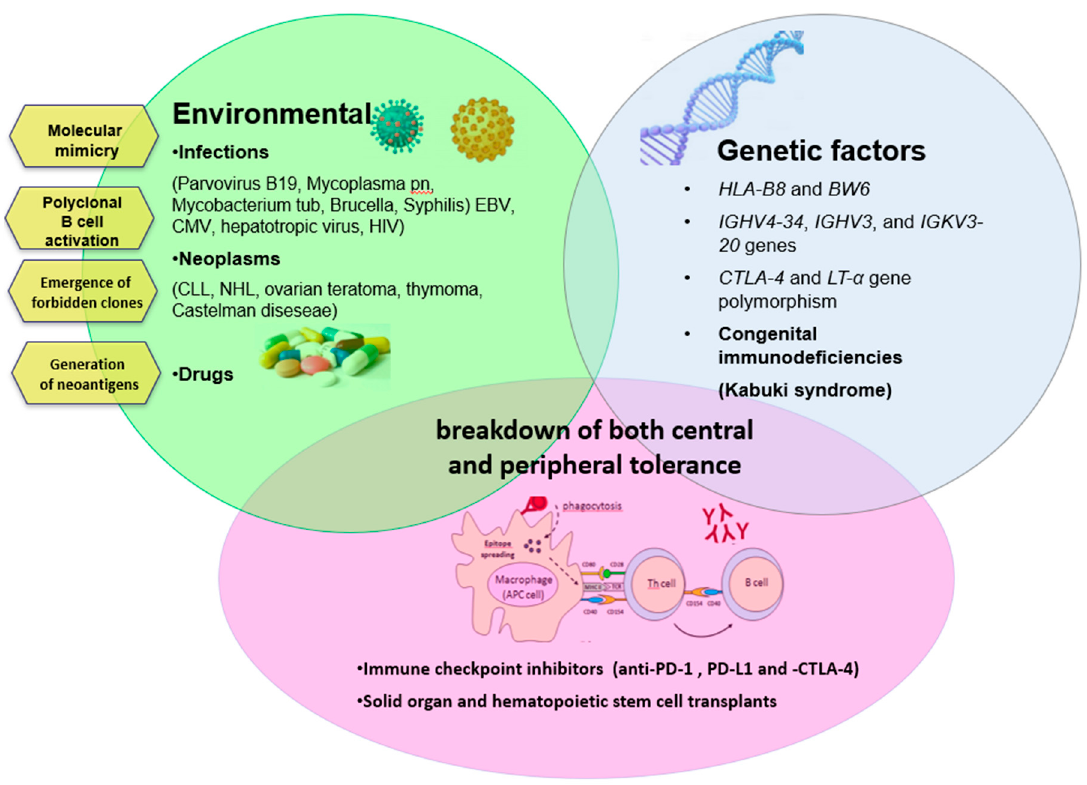
Figure 2. Immunologic, environmental, and genetic factors involved in the pathogenesis of autoimmune hemolytic anemia (AIHA). CLL: chronic lymphocytic leukemia, NHL: non-Hodgkin lymphoma, PD1/-L: programmed death 1 and its ligand, CTLA-4: cytotoxic T-lymphocyte-associated protein 4.